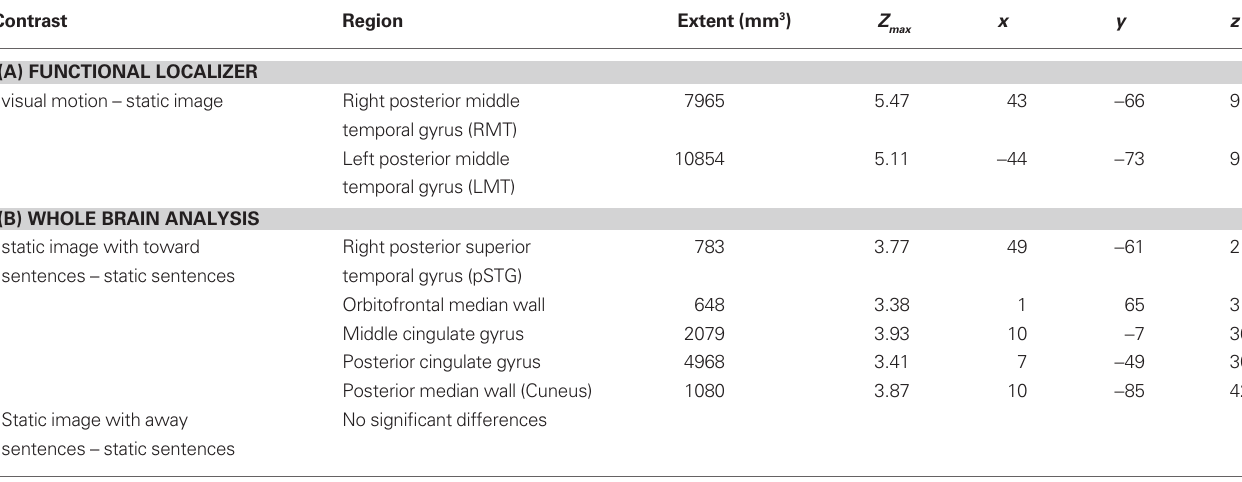
Table 2 | Areas showing significantly different activation (A) within posterior middle temporal gyrus (MT) for the functional localizer and (B) whole brain analysis contrasting different sentence